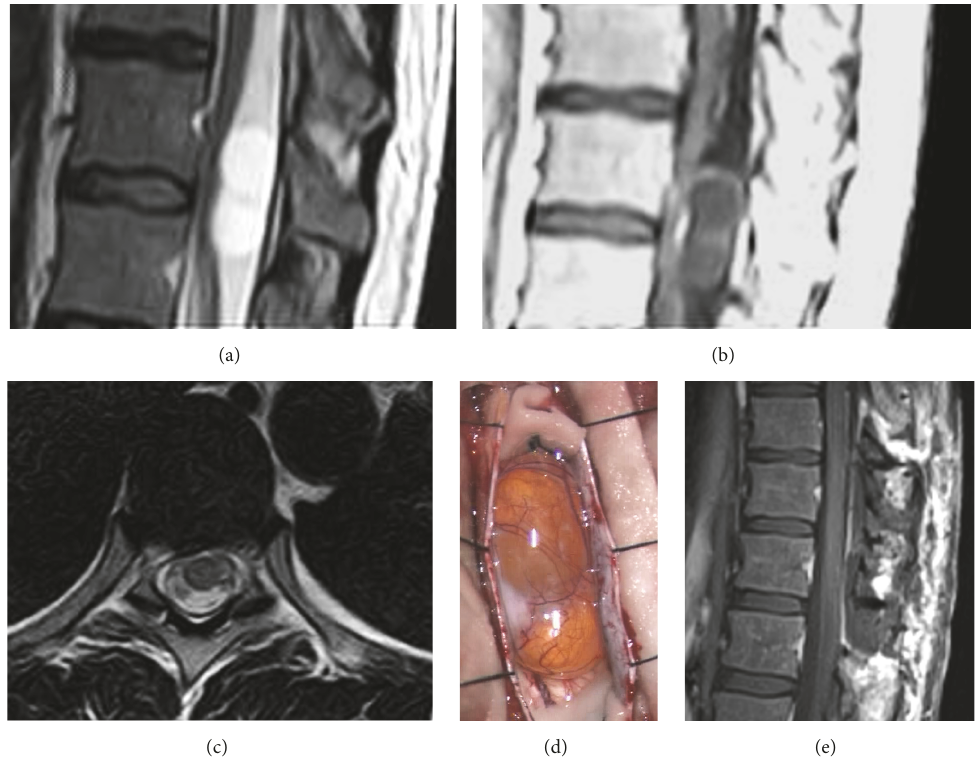
Figure2:Illustrativecase.A43-year-oldwomancametoourobservationcomplainingfrompainontheleftchestwithirradiationtothegroin. Neurological examination showed slightly increased reflexes: (a) MRI T2w sequences, sagittal view, showing a posterior mass with marked cystic degeneration; (b) T1w sequences showing poor peripheral contrast enhancement; (c) T2w sequences, axial view; (d) intraoperative photography showing a neurinoma with marked cystic degeneration; (e) postoperative MRI, T1w sequences, sagittal